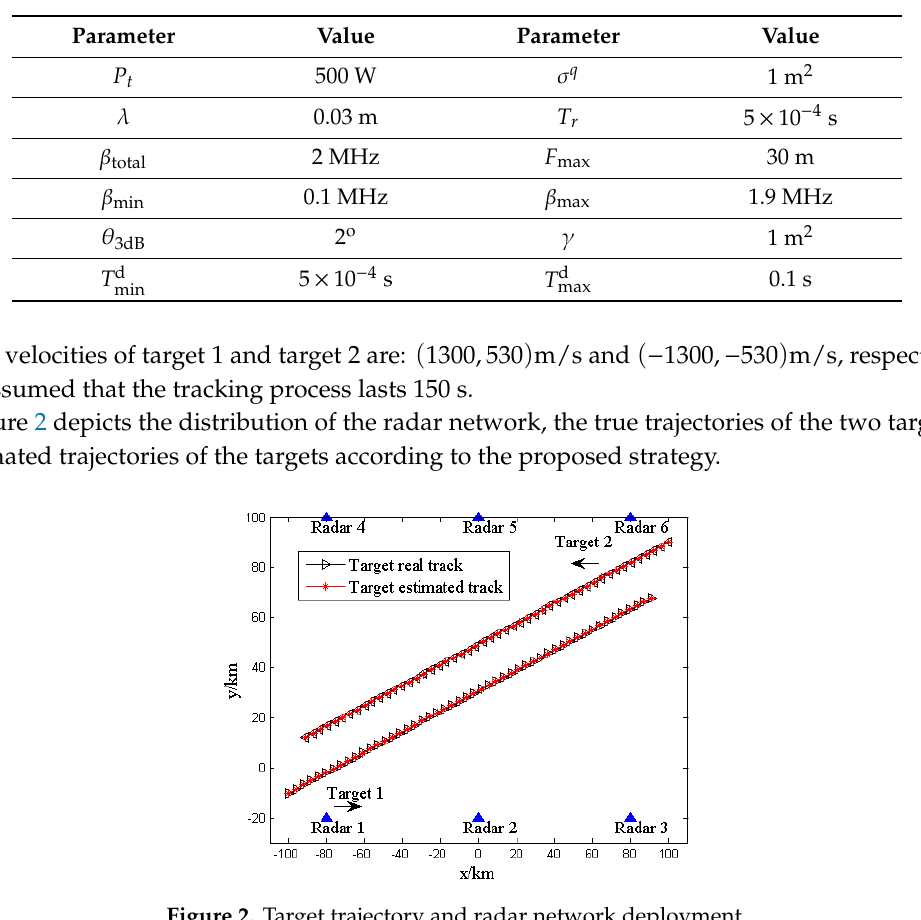
Table 2. Radar network system parameters.